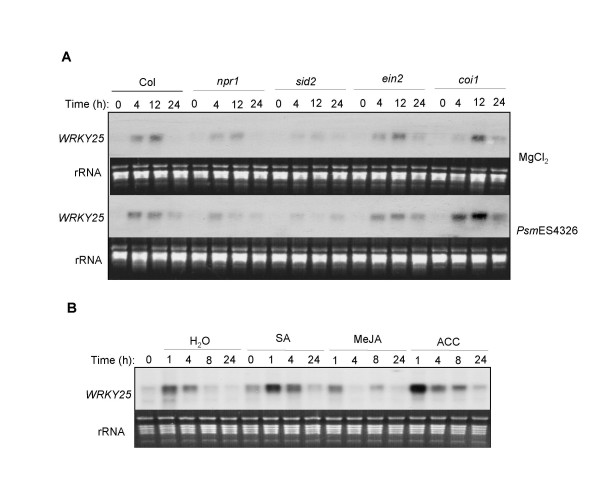
Expression of WRKY25. A. RNA blot analysis of WRKY25 expression in 5-week old wild-type or mutant Arabidopsis. Two fully expanded leaves were infiltrated with 10 mM MgCl2 (mock inoculation) or Psm ES4326 (OD600 = 0.0001 in 10 mM MgCl2) and harvested at the indicated times after inoculation. After separation on a gel and blotting to nylon membrane, the blot was probed with a WRKY25-specific DNA fragment. B. Induced WRKY25 expression in 5-week old wild-type Arabidopsis plants sprayed with H2O, 2 mM SA, 0.1 mM ACC or 0.1 mM methyl JA. Leaves were harvested at the indicated times after treatment and used for preparation of total RNA and RNA blotting. Ethidium bromide stained rRNA was used as a loading control. The experiments were repeated twice with similar results.